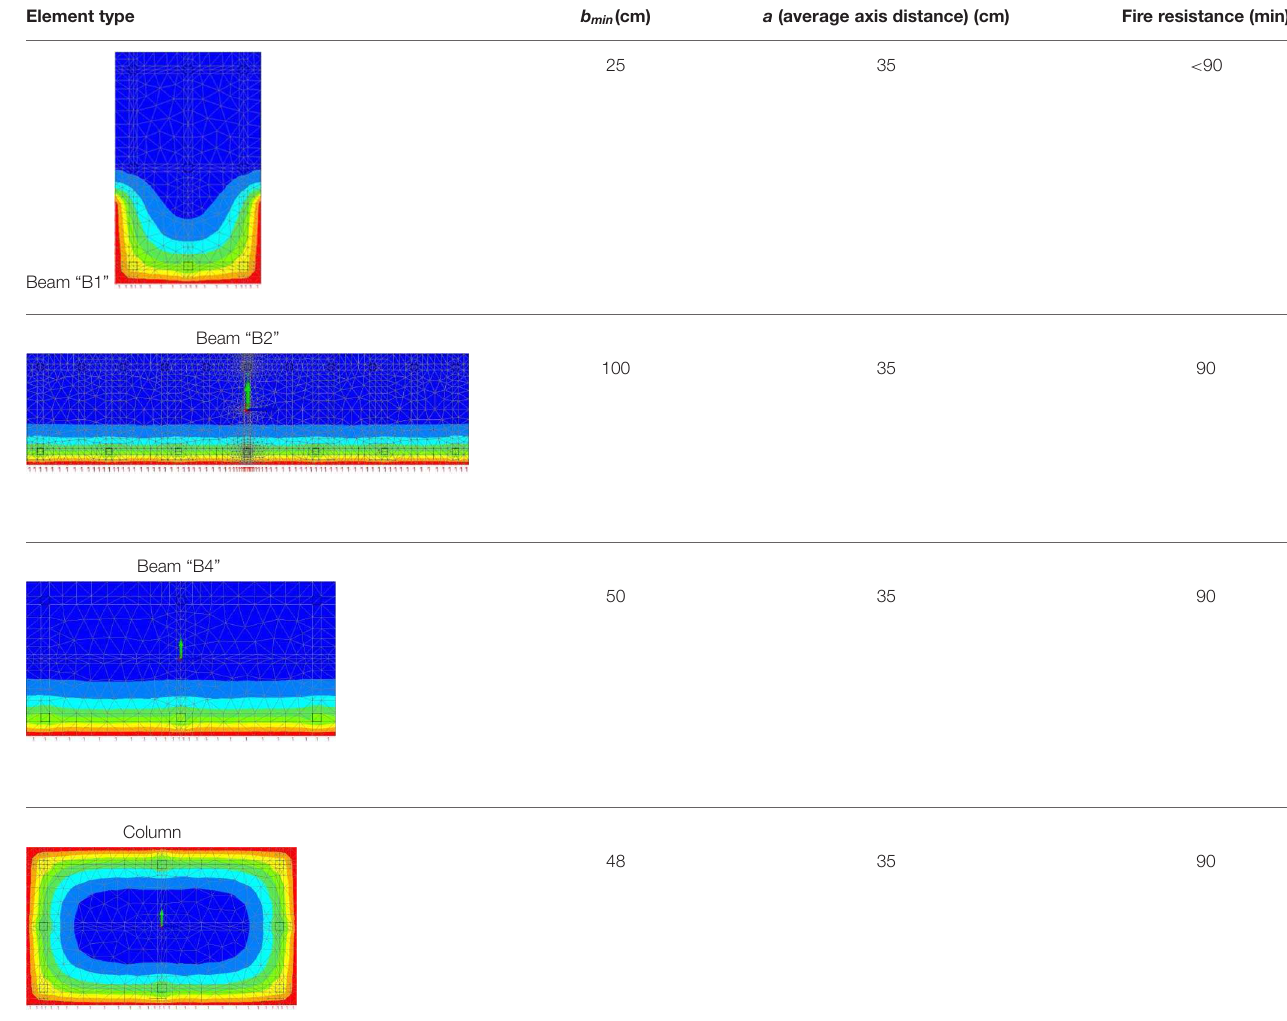
TABLE 2 | Structural element verified according to tabular data of Eurocodes. Element